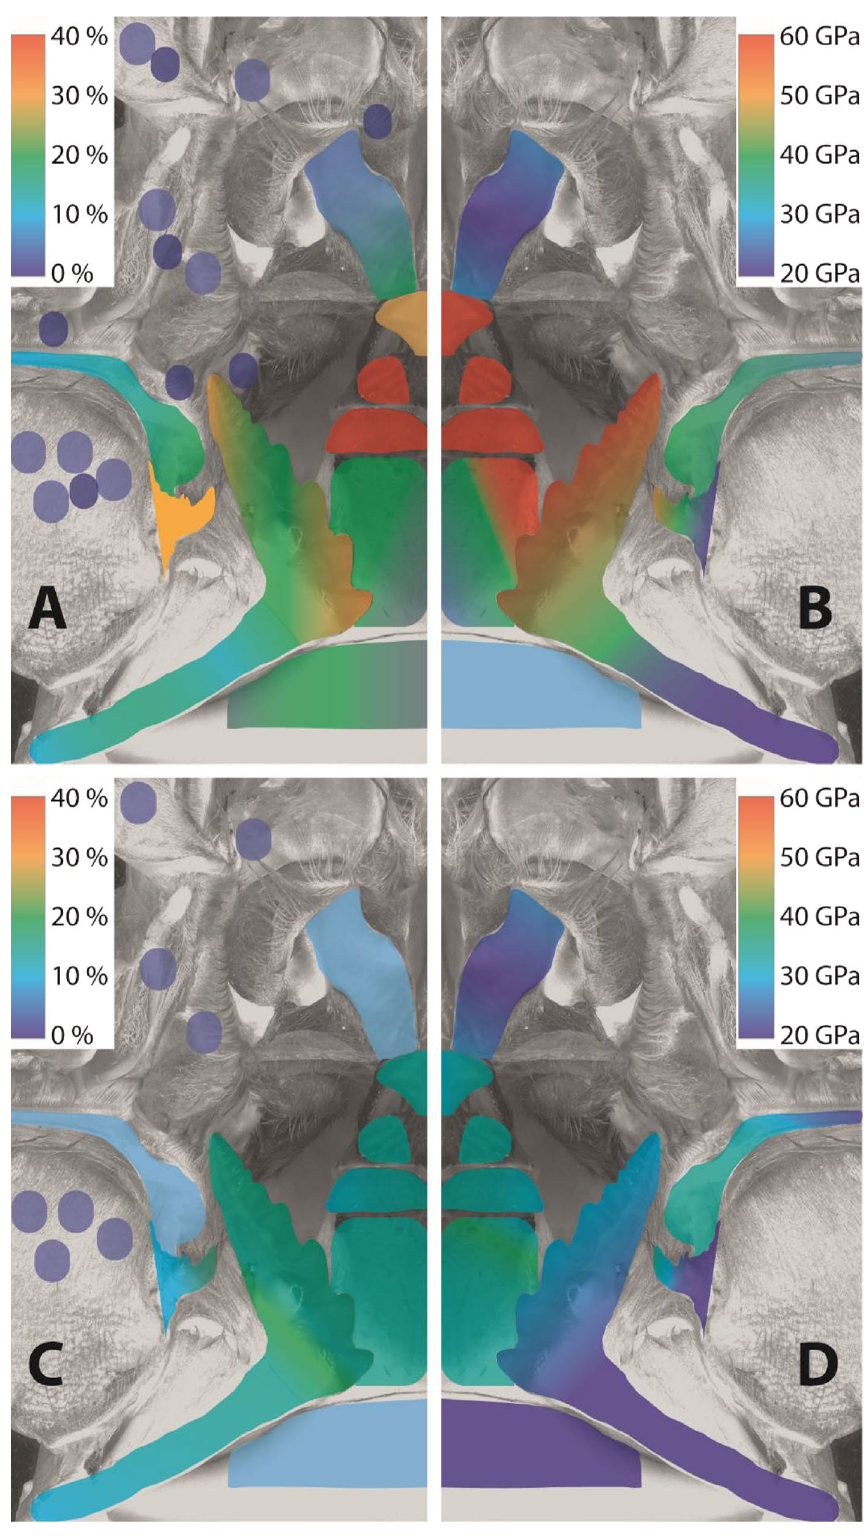
Figure 6. Left side: distribution of all elements (Ae), which are not the basis of chitin, in the epicuticle (above) and the exocuticle (below). Right side: Young’s modulus of the epicuticle (above) and the exocuticle (below). For the material property gradients, we used the mean values of the tested localities, rounded them to either 0%, 10%, 20%, 30%, and 40% for the elemental composition and to 20 GPa, 30 GPa, 40 GPa, 50 GPa, and 60 GPa for the Young’s modulus. The smallest value (0% and 20 GPa) was assigned to the color dark blue and the highest value (40% and 60 GPa) to red. These colors were then assigned to the localities tested by creating areas in illustrator, which were colored employing the illustrator gradient